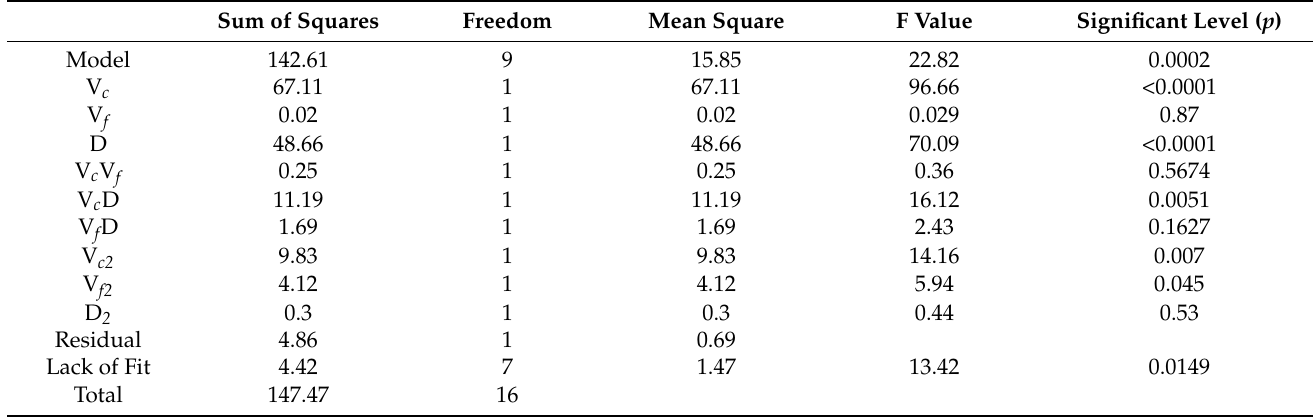
Table 3. Variance analysis of regression equation.